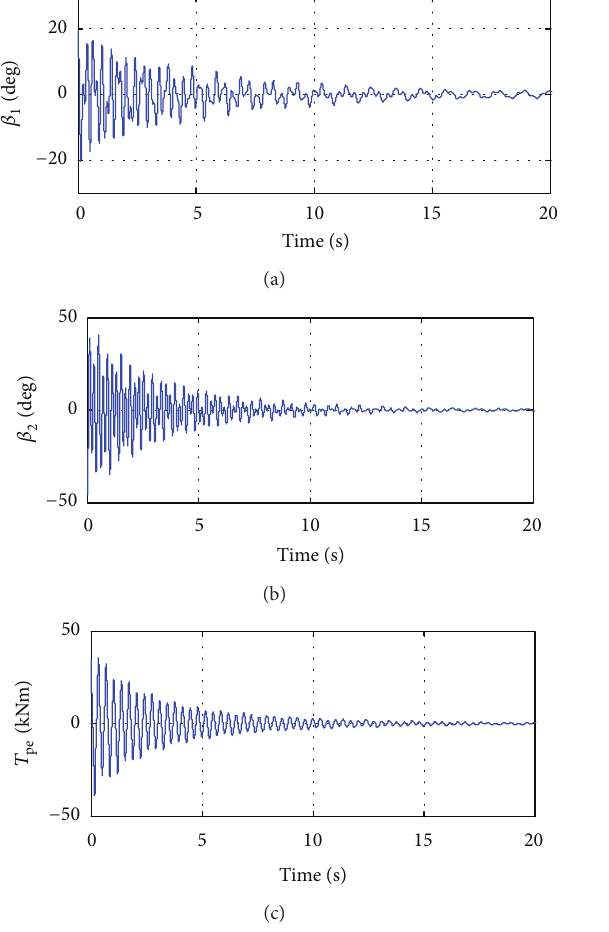
Figure 8: Control surface deflection angles and actuator torques for exact feedback linearisation: cancellation of nonlinearity only, with assignment of